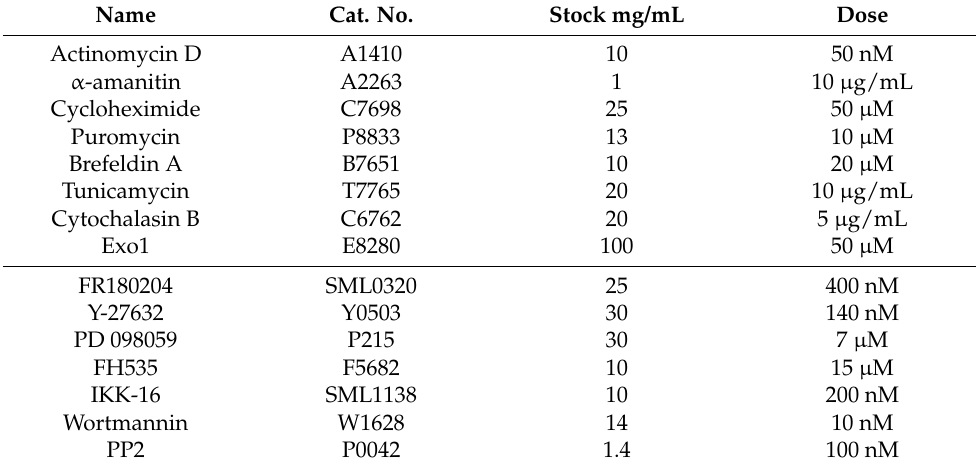
Table 2. List of inhibitors used in this